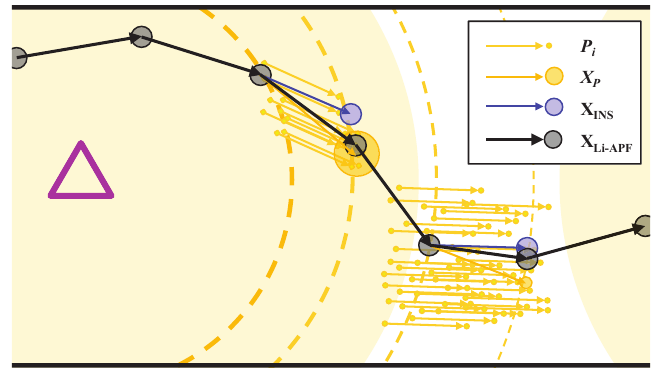
Figure 5. Brief representation of the process of the proposed